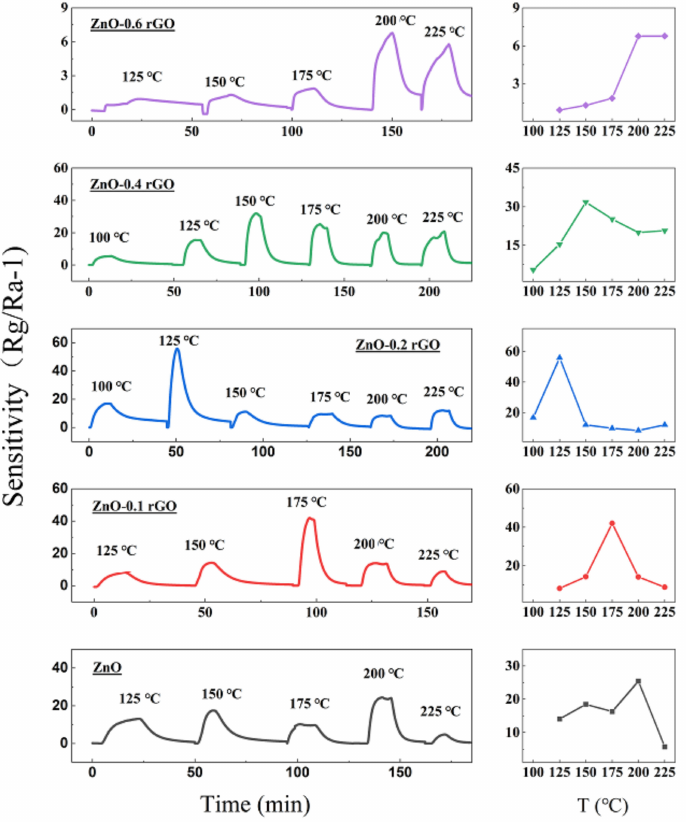
Figure 6. Response curves of the ZnO-x rGO (x = 0, 0.1, 0.2, 0.4, 0.6) with temperature (100–225 ◦ C) at a concentration of 4 ppm NO 2 on the left.